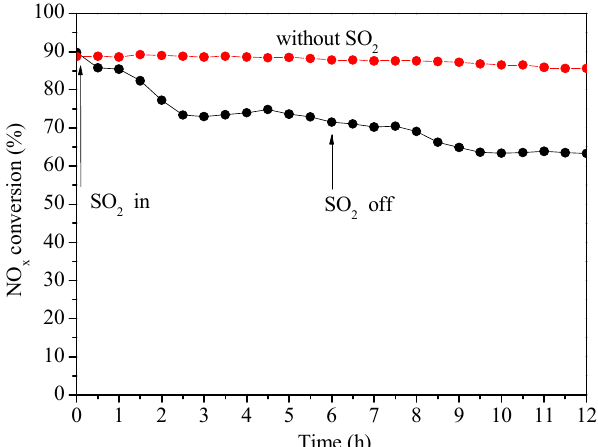
Figure 9. Catalytic activity of Ce 0.3 /ARM in the presence of SO 2 and without SO 2 . Reaction conditions: Reaction temperature = 300 ◦ C, reaction gas pressure = 0.1 MPa, N 2 balance, total flow = 2000 mL · min − 1 , GHSV = 30,000 h − 1 , n[NH 3 /NO] = 1.0, initial concentration of NH 3 , NO, O 2 and SO 2 = 0.05%, 0.05%,